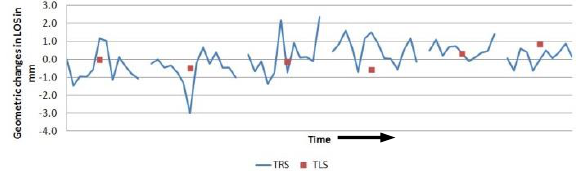
Figure 7: Comparison of TRS (blue) and TLS (red) measurements of a pixel where no geometric